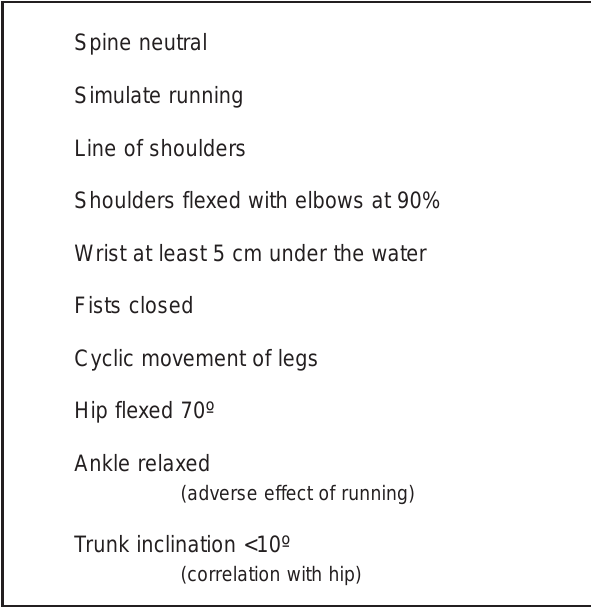
Figure 3. Deep water running